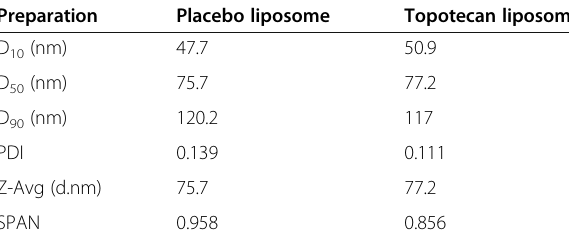
Table 11 Results of dynamic light scattering (particle size) of topotecan liposome and placebo liposome